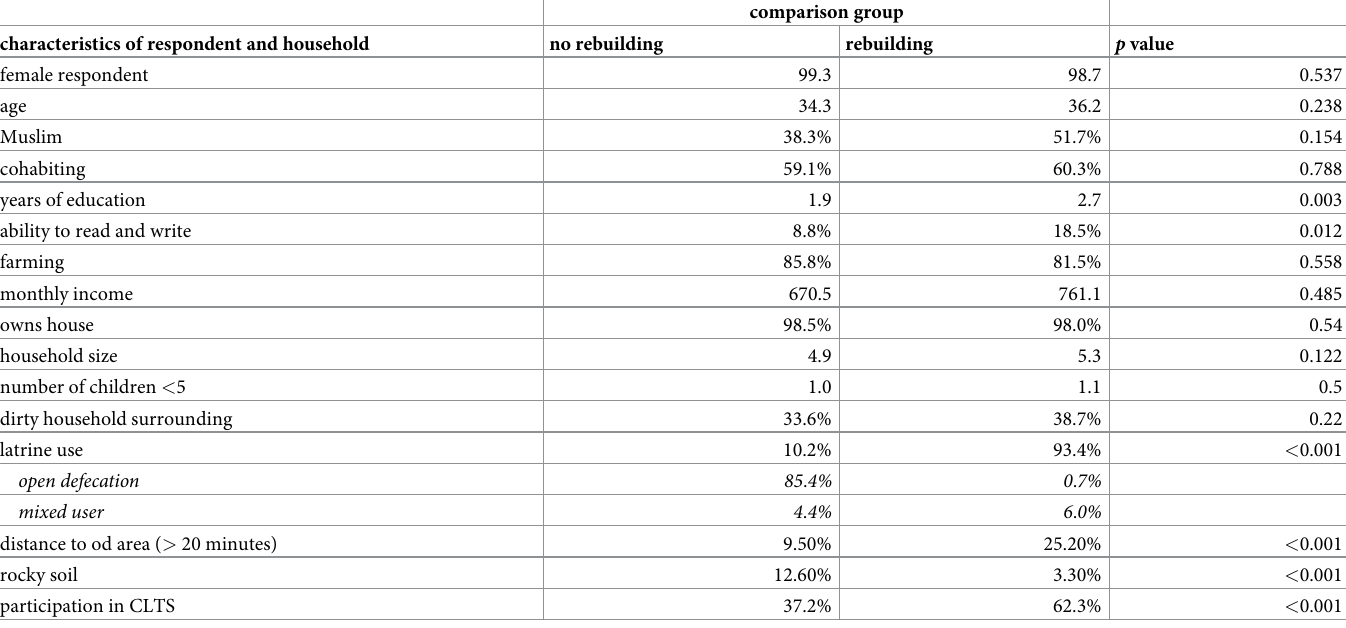
Table 1. Characteristics of the